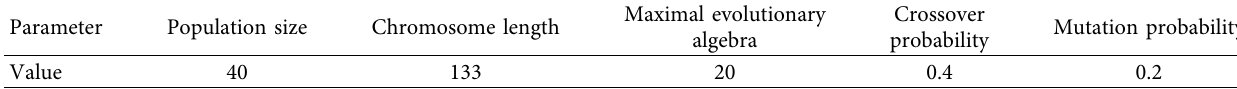
Table 10: Parameters used in the genetic